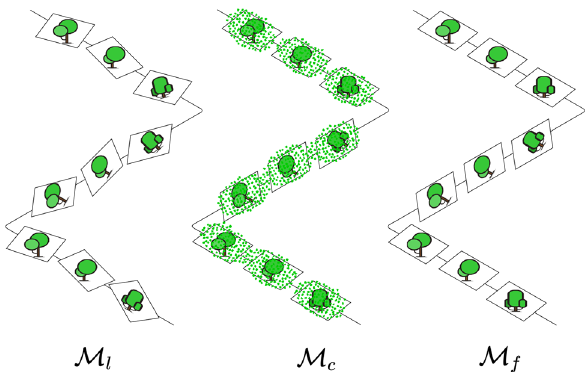
Fig. 5 Schematic showing the 2 intermediate maps M c , M l and the final map M f . Snapshots of M c and M f are shown in Fig. 11